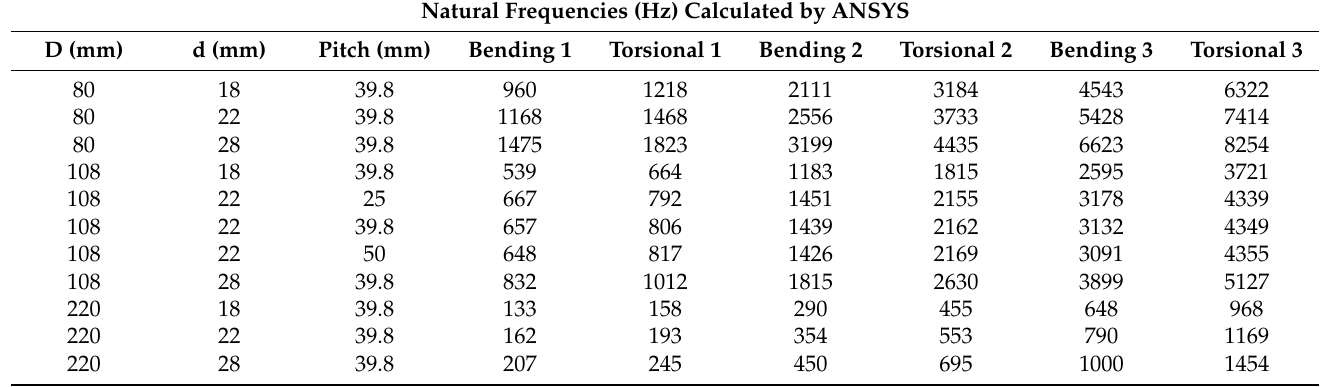
Table 2. FEM calculation of the first natural frequencies (Hz) of helical spring. Natural Frequencies (Hz) Calculated by